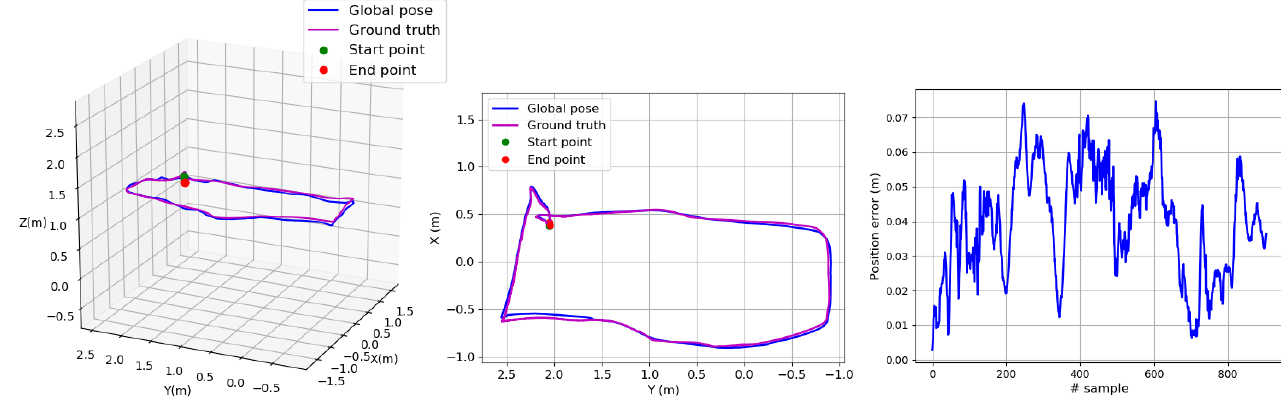
Figure 10. Tele-operated flight following a rectangle-like path at constant altitude: ( left ) estimated and true paths, ( middle ) 2D projection of the trajectory, ( right ) position estimation error. (All values are in